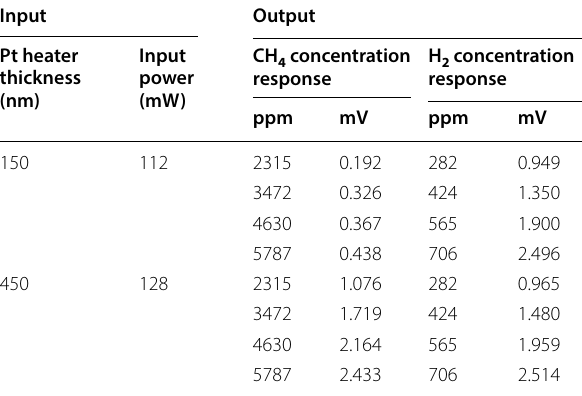
Table 1 Responses to methane and hydrogen gas concentrations of fabricated catalytic combustible type single-chip micro gas sensors with two different Pt heater thicknesses and input